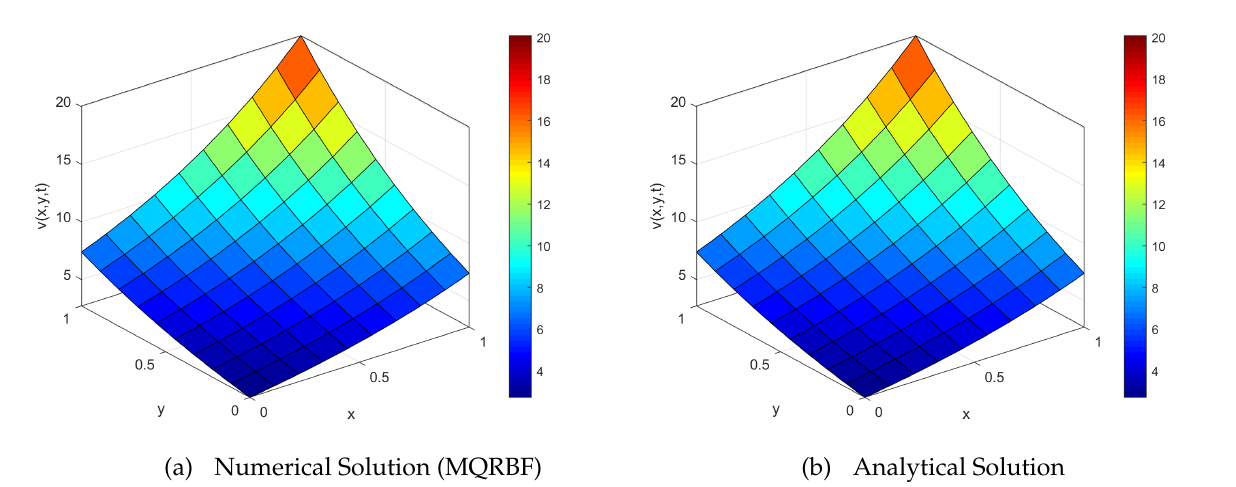
Figure 5. Comparison between solution profiles of v with h = 1/9, k = 0.01 at t =